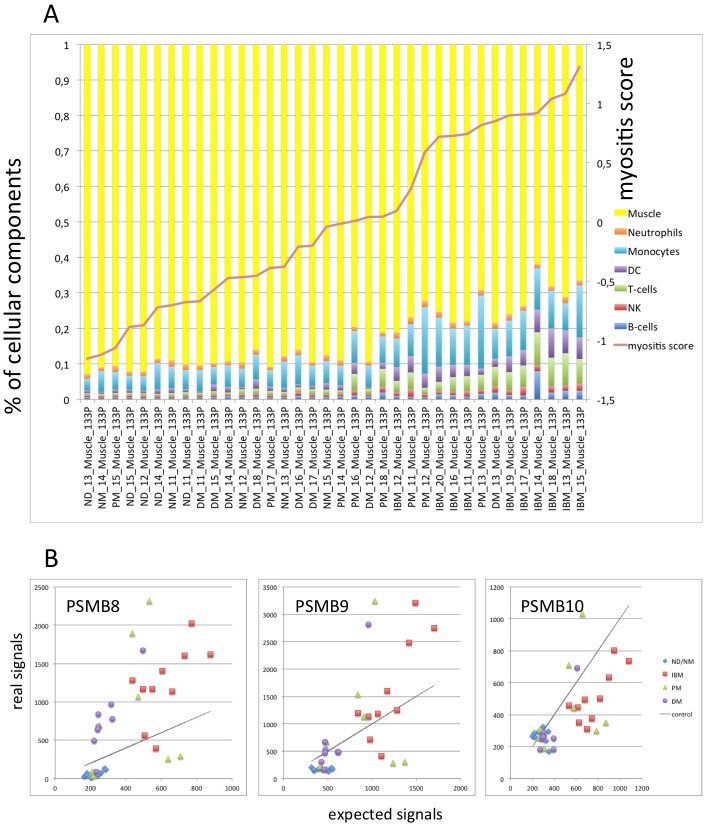
Quantification of cellular infiltration and confirmation of PSMB8/-9 gene activation in myositis muscle samples:Transcriptome data referenced in table S2 were re-investigated. A) Cell type infiltration was quantified based on the expression of cell specific marker transcripts (figure S5). Signal ratios between muscle biopsy and purified cell type were calculated for each cell type specific transcriptional markers. Taking the median of the ratios in each cell specific marker set and scaling their sum to 100% revealed an estimate of the cellular composition. Increase of monocyte, dendritic cell and T-cell transcription patterns corresponds to the molecular myositis score. (ND = normal donor; NM = necrotizing myopathy). B) The maximum of infiltration related signal intensity was calculated as described in materials and methods. Comparing these expected intensities (x-axis) with real intensities (y-axis) in each sample, PSMB8 and PSMB9 are higher expressed than expected in the majority of IBM and several of the PM muscle. In DM, PSMB8 expression also exceeds the expected signal intensity, although on a lower level. One out of the 8 DM samples (DM_13) showed consistently a pattern similar to the highly inflamed IBM samples. All other conditions including controls remained below the expected intensity. For PSMB10, the increased signal intensity in several samples of IBM seems to correspond to the level of infiltration.